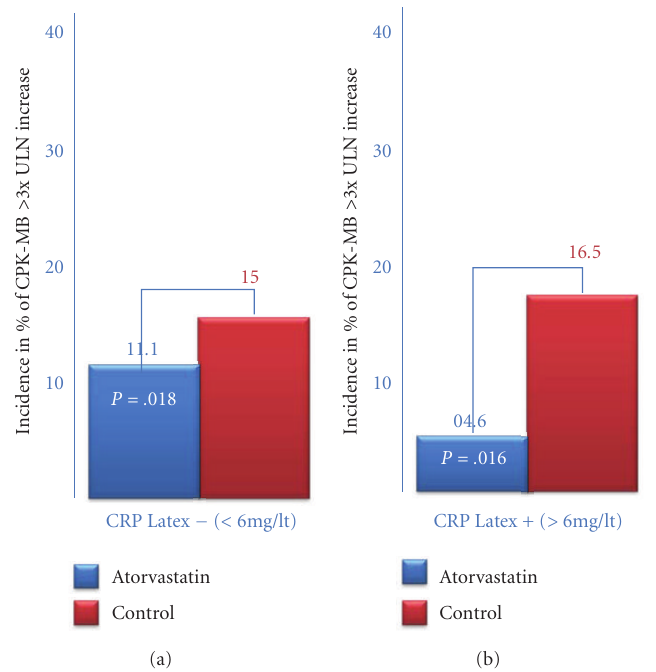
Figure 7: NAPLES II Study. This modified graphic of the NAPLES II study, confirmed with a randomized study, as compared to a control group, the favorable e ff ect of statins before PCI. In individuals with stable coronary syndromes, statin-naive undergoing elective PCI, the administration of atorvastatin 80 mg/24 hours before PCI significantly reduces the incidence of MI-PCI associated (CPK-MB > 3x ULN, 2007 criteria). As can be seen, the benefit was especially significant in the subgroup of individuals with CRP > 6mg/L before PCI, in this subgroup the incidence of MI-PCI associated was 16.5% in the control group versus 4.6% in the atorvastatin group with P = . 016.